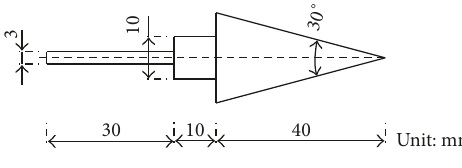
Figure 1: Cone structure